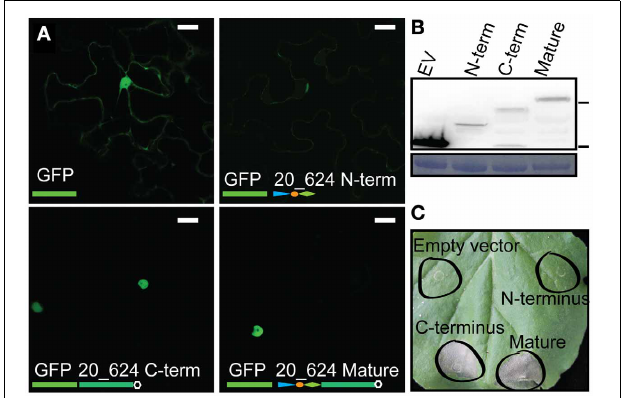
FIGURE 1 | CRN induced cell death and nuclear localization is conferred by the C-terminus. (A) Localization of ectopically expressed CRN-GFP fusion products. The panels show the localization for free eGFP, CRN20_624 N-terminus, CRN20_624 C-terminus, and mature CRN20_624 protein, 2 days post infiltration at OD 0.1 Scale bar = 25 μ m. (B) Immunoblot analysis of CRN20_624 upon over-expression in plant tissue. The blot was probed with anti-GFP antibody. 70 and 25kDa markers are indicated on the right hand side. Lower panel shows coomassie